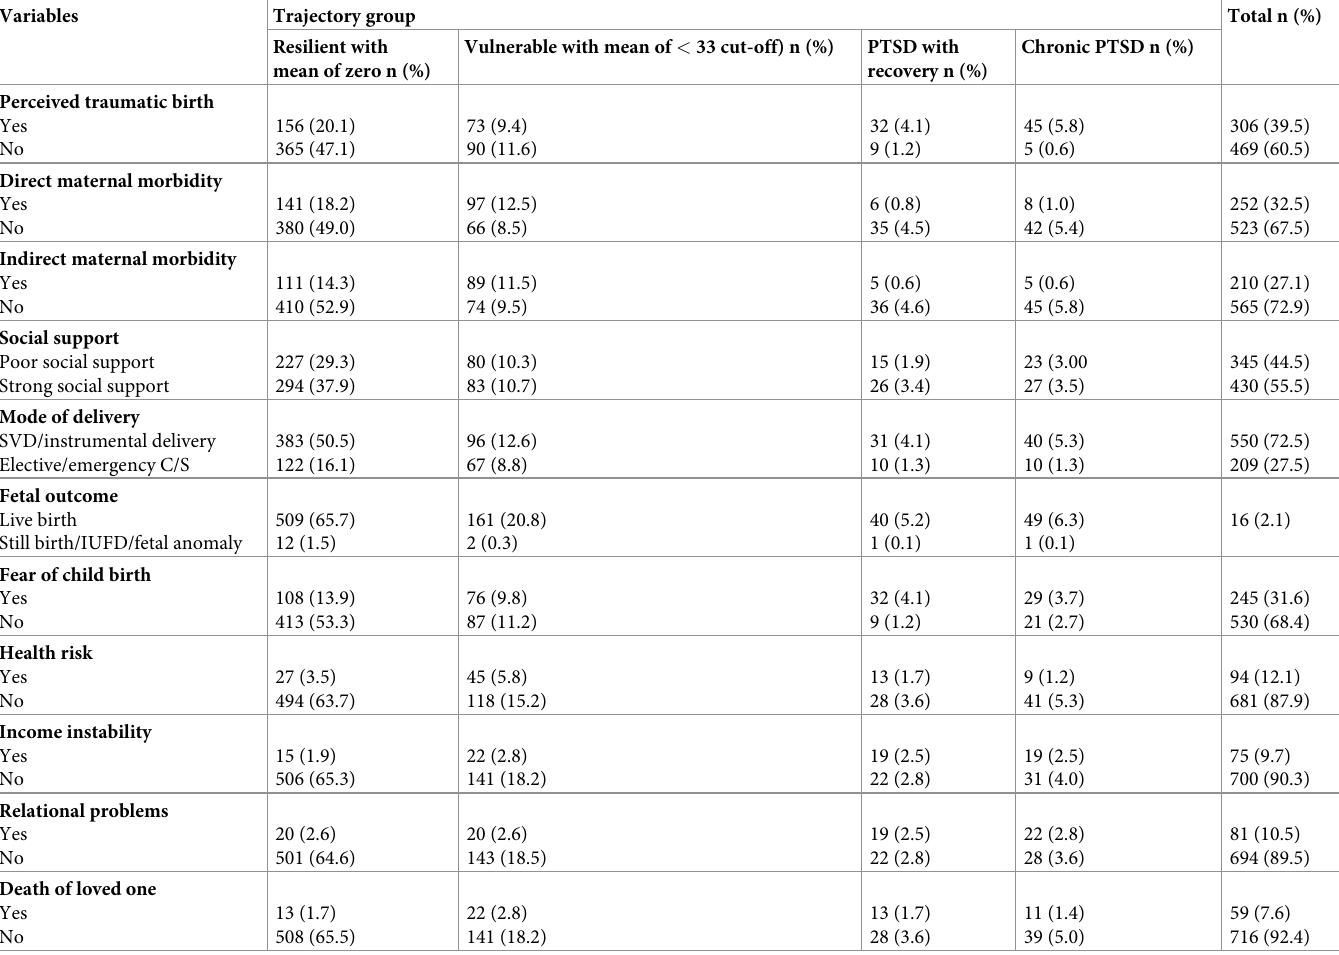
Table 3. Obstetrics and psychosocial variables by PTSD trajectory groups among postpartum women in Northwest Ethiopia, 2021.